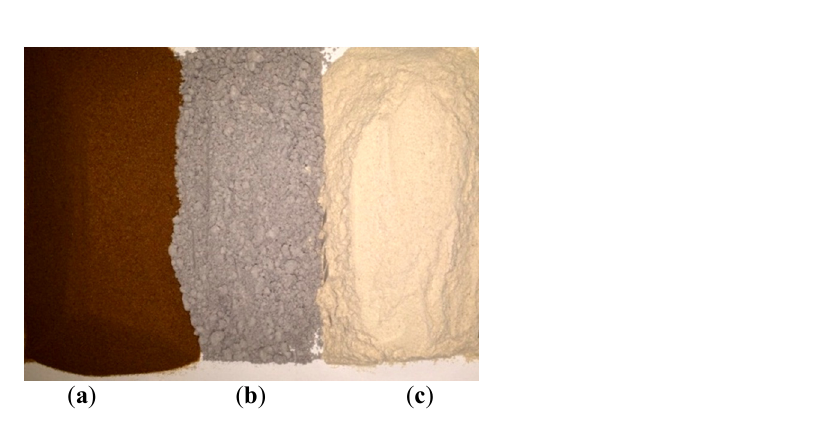
Table 4. Composition of developed plastic-based green lightweight aggregates. Sr. No.